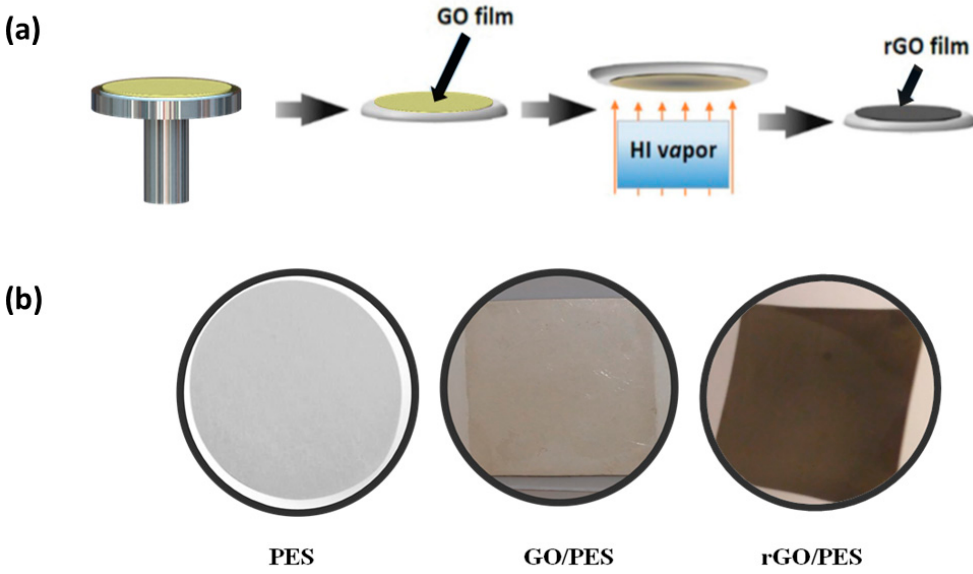
Figure 1. ( a ) Schematic diagram showing the GO spin coating and reduction process; ( b ) photographs of the bare-PES, GO-2min PT-PES, and rGO-2min PT-PES membranes.